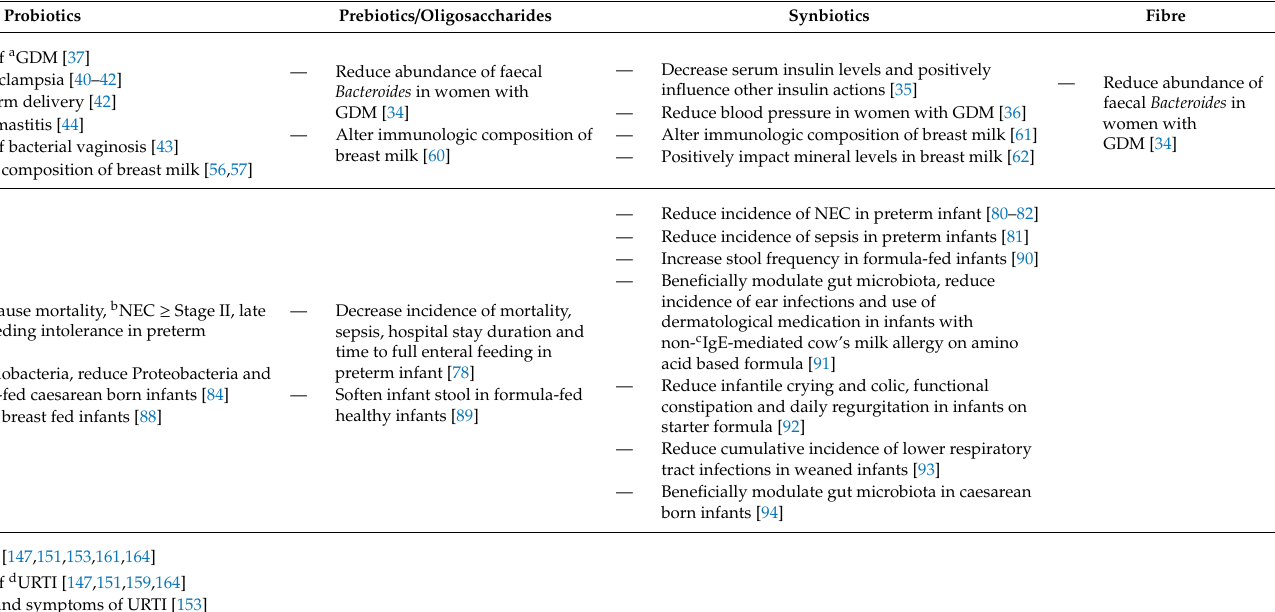
Table 1. Potential benefits of probiotics, prebiotics, synbiotics and fibre on di ff erent life